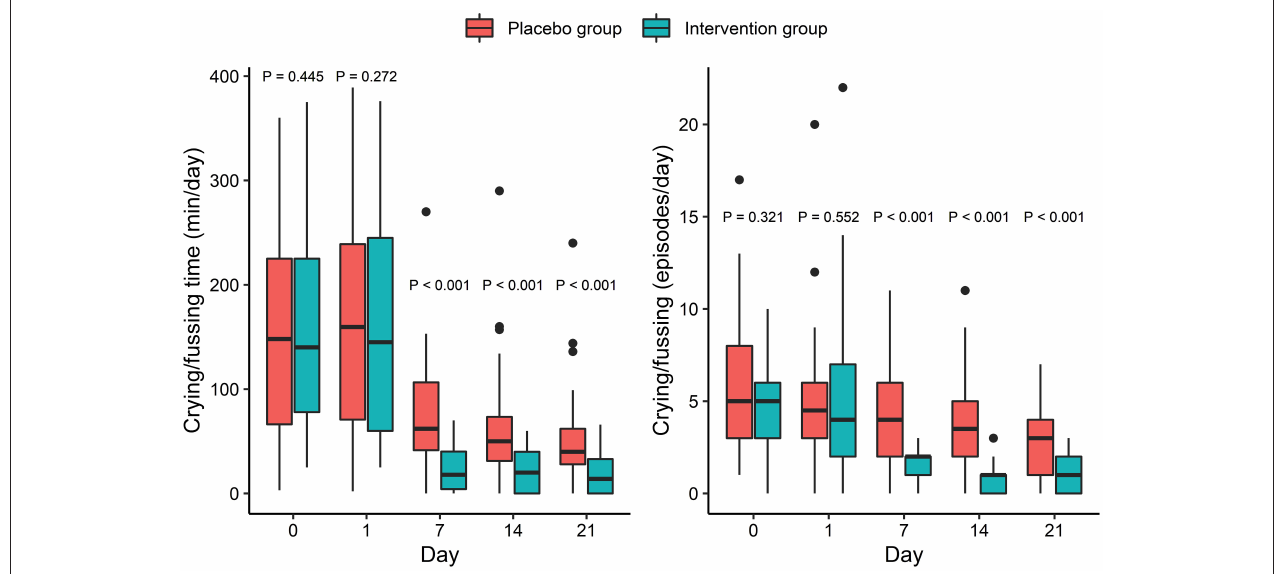
FIGURE 2 | Effect of intervention on crying/fussing time (left) and number of crying/fussing episodes (right). P-values correspond to Kruskal-Wallis test performed at each timepoint. Box and whiskers denote quartiles and 95% percentiles.